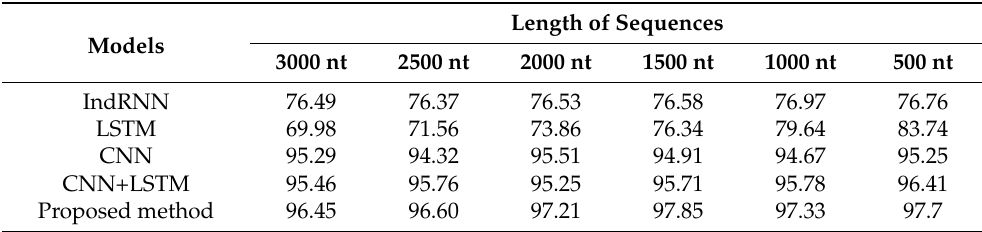
Figure 6. The distribution of our dataset. Table 5. Comparison analysis of the proposed models with different lengths of sequences and different deep learning models.